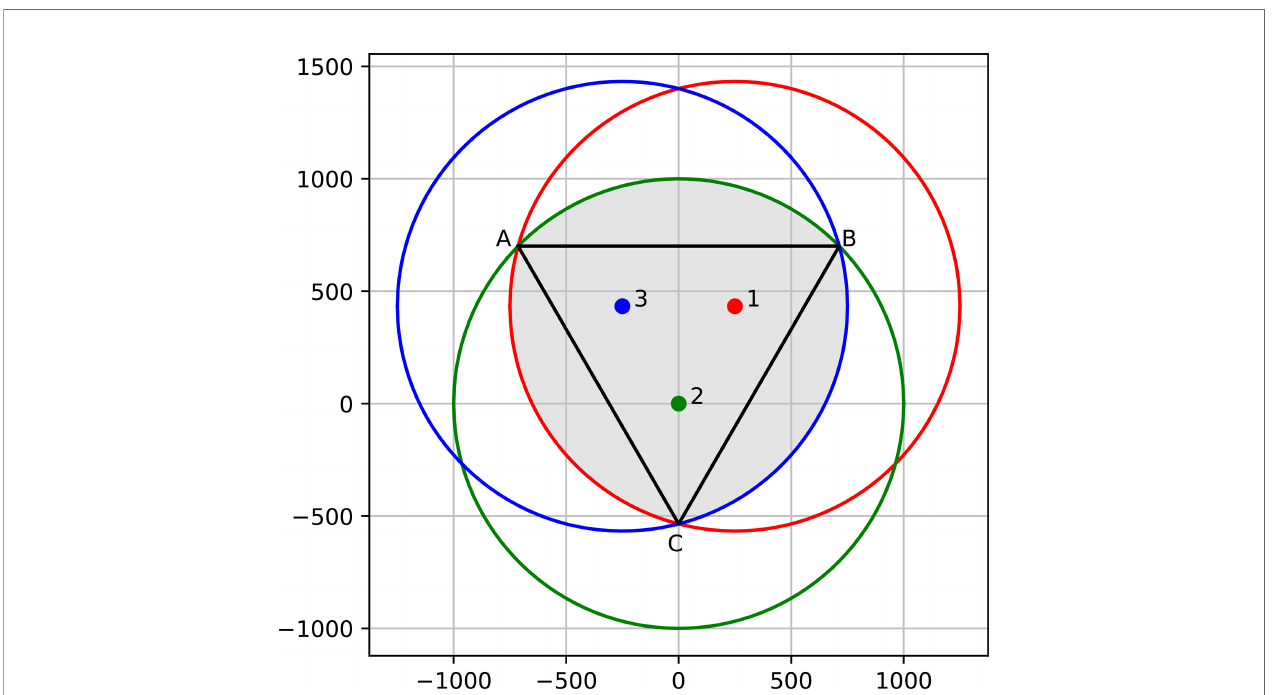
FIGURE 10 | The receivers ’ position are marked by numbers; the intersections between the contour of the receiving ranges are marked by letters. The shaded area is the usable receiving area S . The distance between the 3 receivers is 0 ≤ x ≤ R